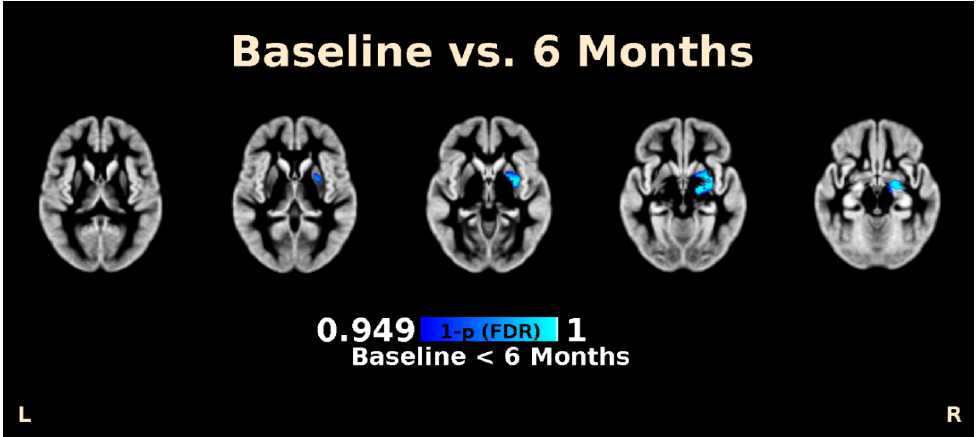
Figure 2. Voxel-based morphometry (VBM) analysis of brain MRI imaging of patients at baseline and 6 months post laparoscopic sleeve gastrectomy. Images above shows significant increases in brain volume in the amygdala and putamen after adjusting for false discovery rate (FDR). Inferior to superior cross-sectional images are presented from left to right. By analyzing the resting state pairwise connectivity of the brain, we found that patients had lower connectivity between the precuneus and the putamen at 6 months after surgery compared to baseline ( p .adj = 0.046). The connectivity between the precuneus to the putamen across both timepoints was positively correlated to the YFAS symptom count ( p -Value = 0.013) (Figure 3). This change in brain connectivity was not significantly correlated with either scores for anxiety or depression or any of the subscales of the TFEQ-R21.